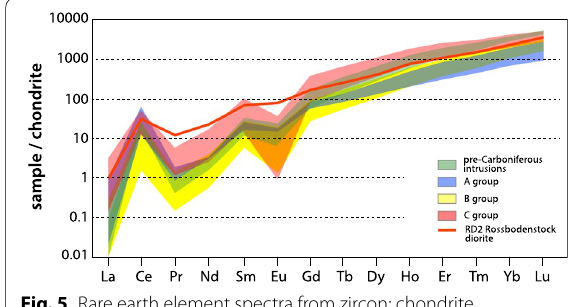
Fig. 5 Rare earth element spectra from zircon; chondrite normalization of McDonough and Sun (1995)